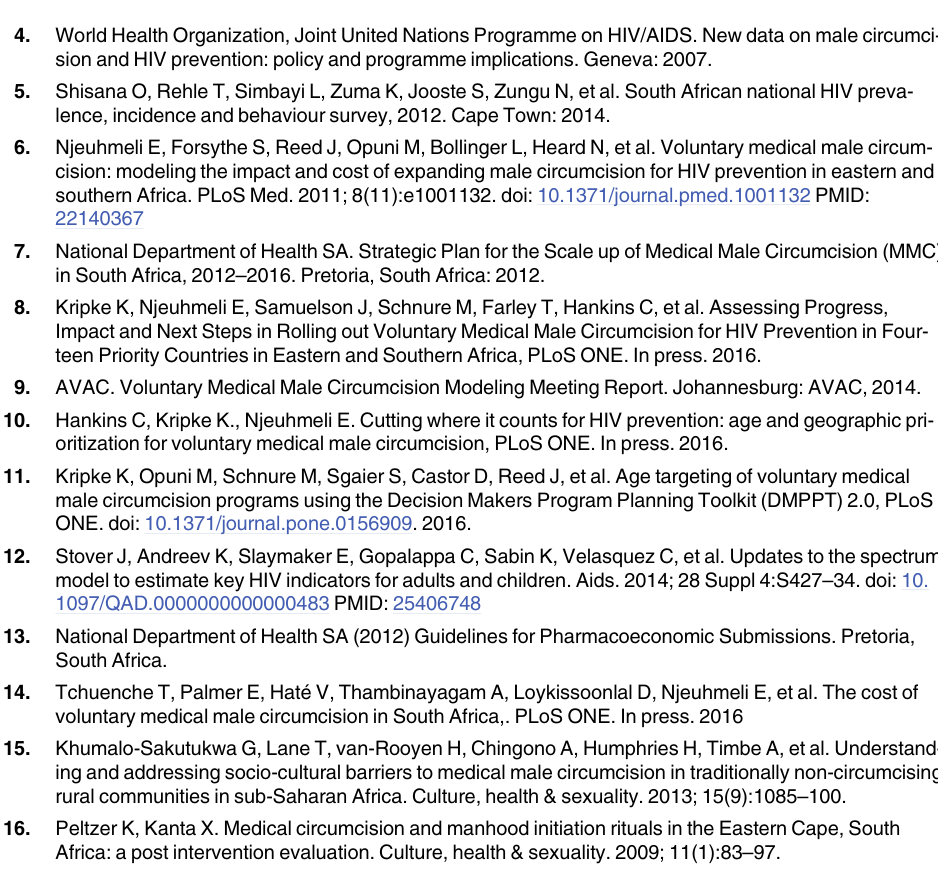
PLOS ONE | DOI:10.1371/journal.pone.0157071 July 13,